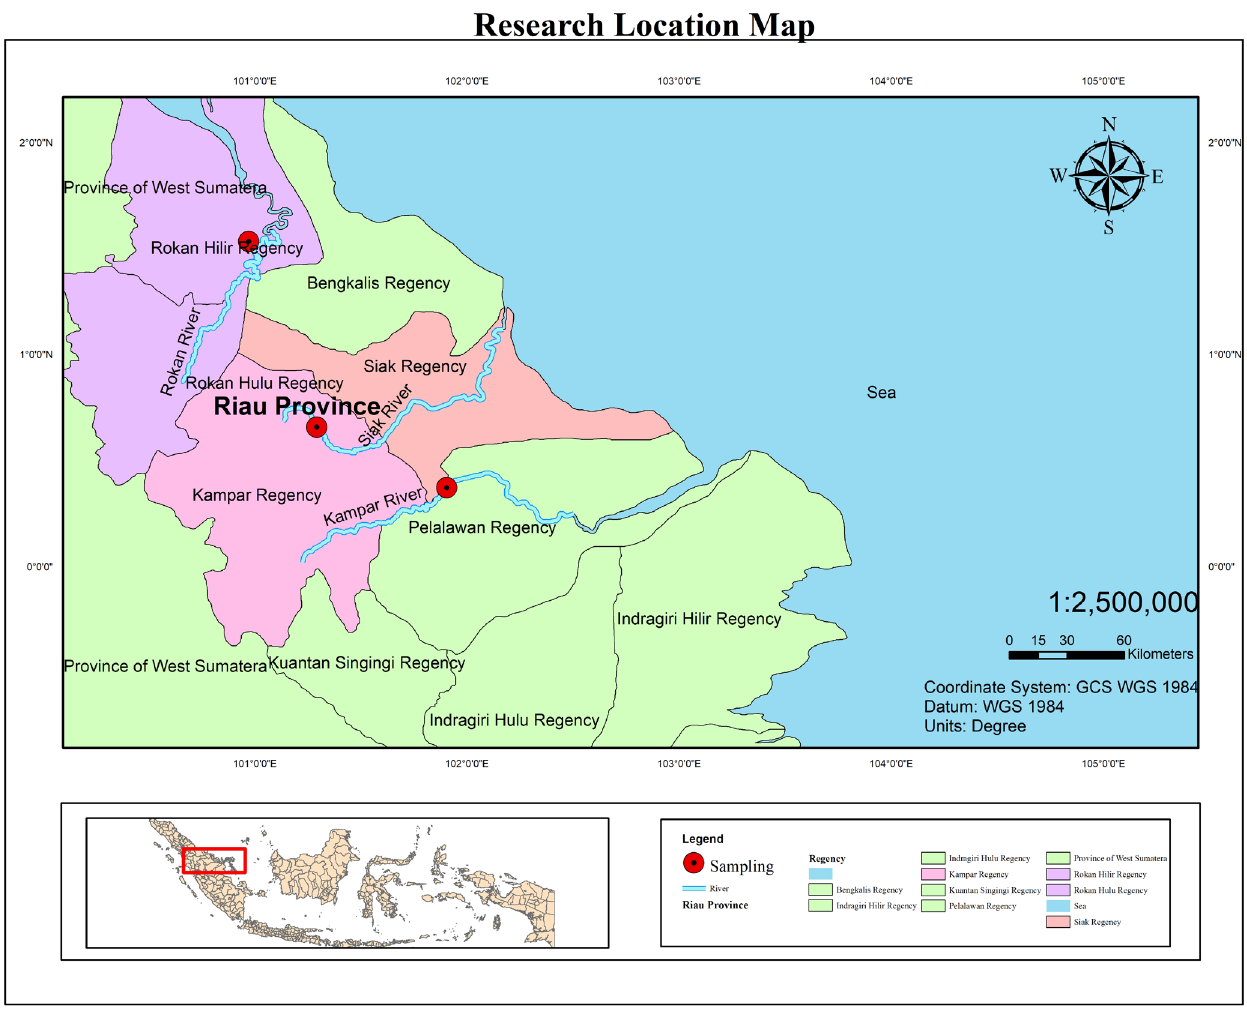
Figure 1. Sample sites for Osteochilus melanopleurus from the Siak (N: 00°39’22.28’’ and E: 101°17’28.67’’), Kampar (N: 00°22’13.64’’ and E: 101°54’11.97’’) and Rokan rivers (N: 01°22’33.65’’ and E: 100°58’26.76’’), Riau Province,